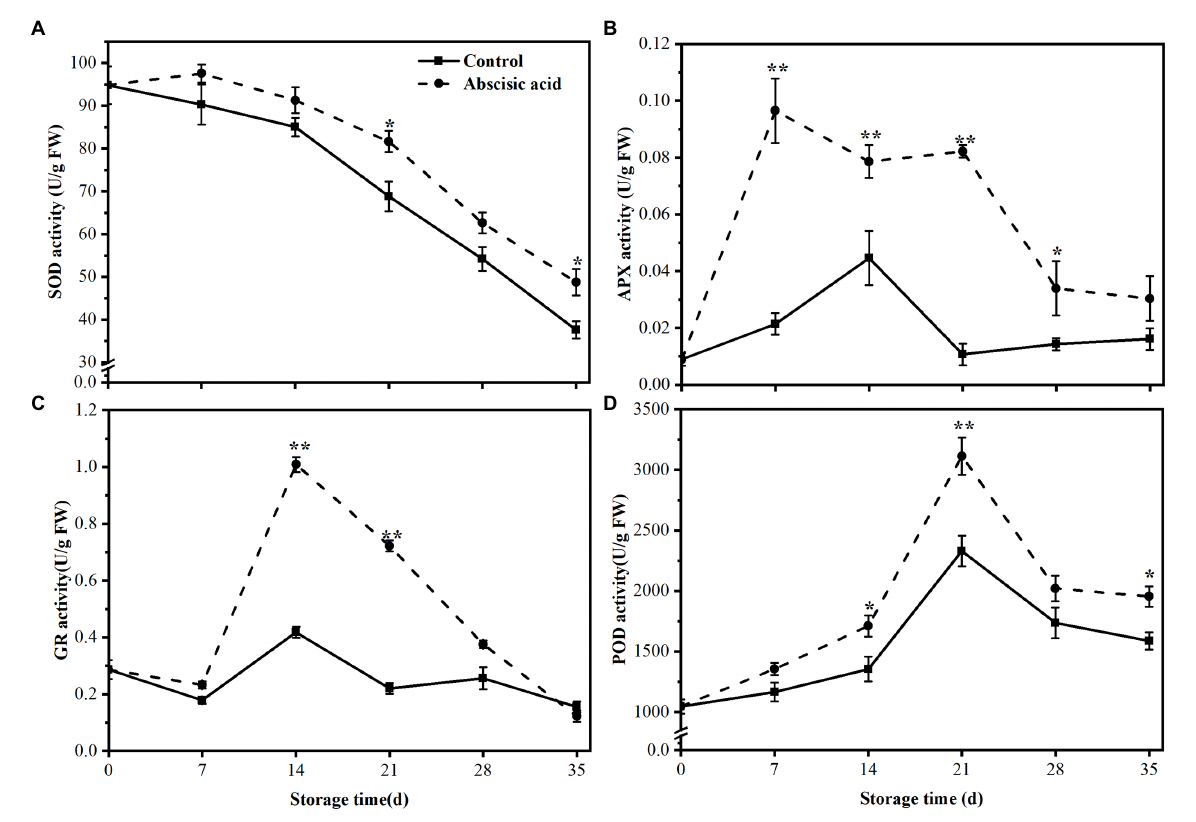
FIGURE 6 Activity of (A) Superoxide dismutase (SOD), (B) ascorbate peroxidase (APX), (C) glutathione (GR), and (D) peroxidase (POD) of peach fruit treated with abscisic acid (ABA) during storage at 4 ° C. The symbol (*) indicates significant differences among different treatments at p < 0.05. The symbol ( ** ) indicates significant differences among different treatments at p <